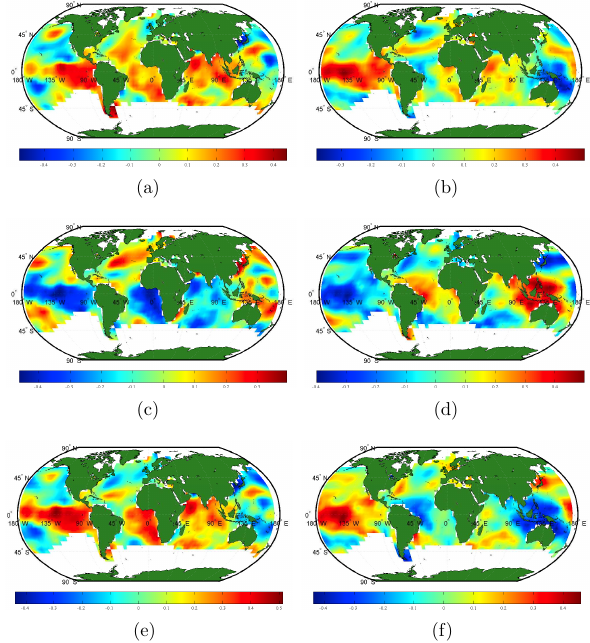
Fig. 4. Correlation maps between SSTa in the monsoon summer season (JJAS) and PCs. (a) China PC1 vs. SSTa; (b) China PC2 vs. SSTa; (c) India PC1 vs. SSTa; (d) India PC2 vs. SSTa; (e) Joint PC1 vs. SSTa; (f) Joint PC2 vs.